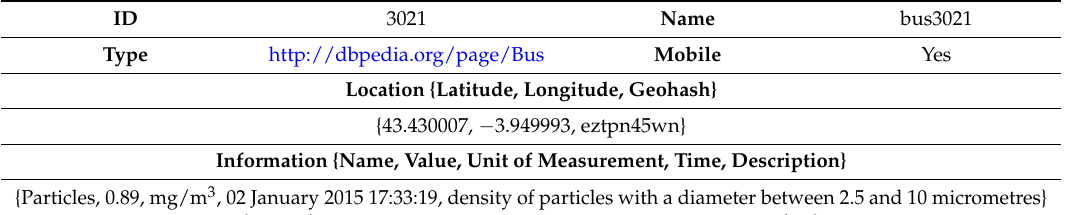
Table 3. Example of VO instance.